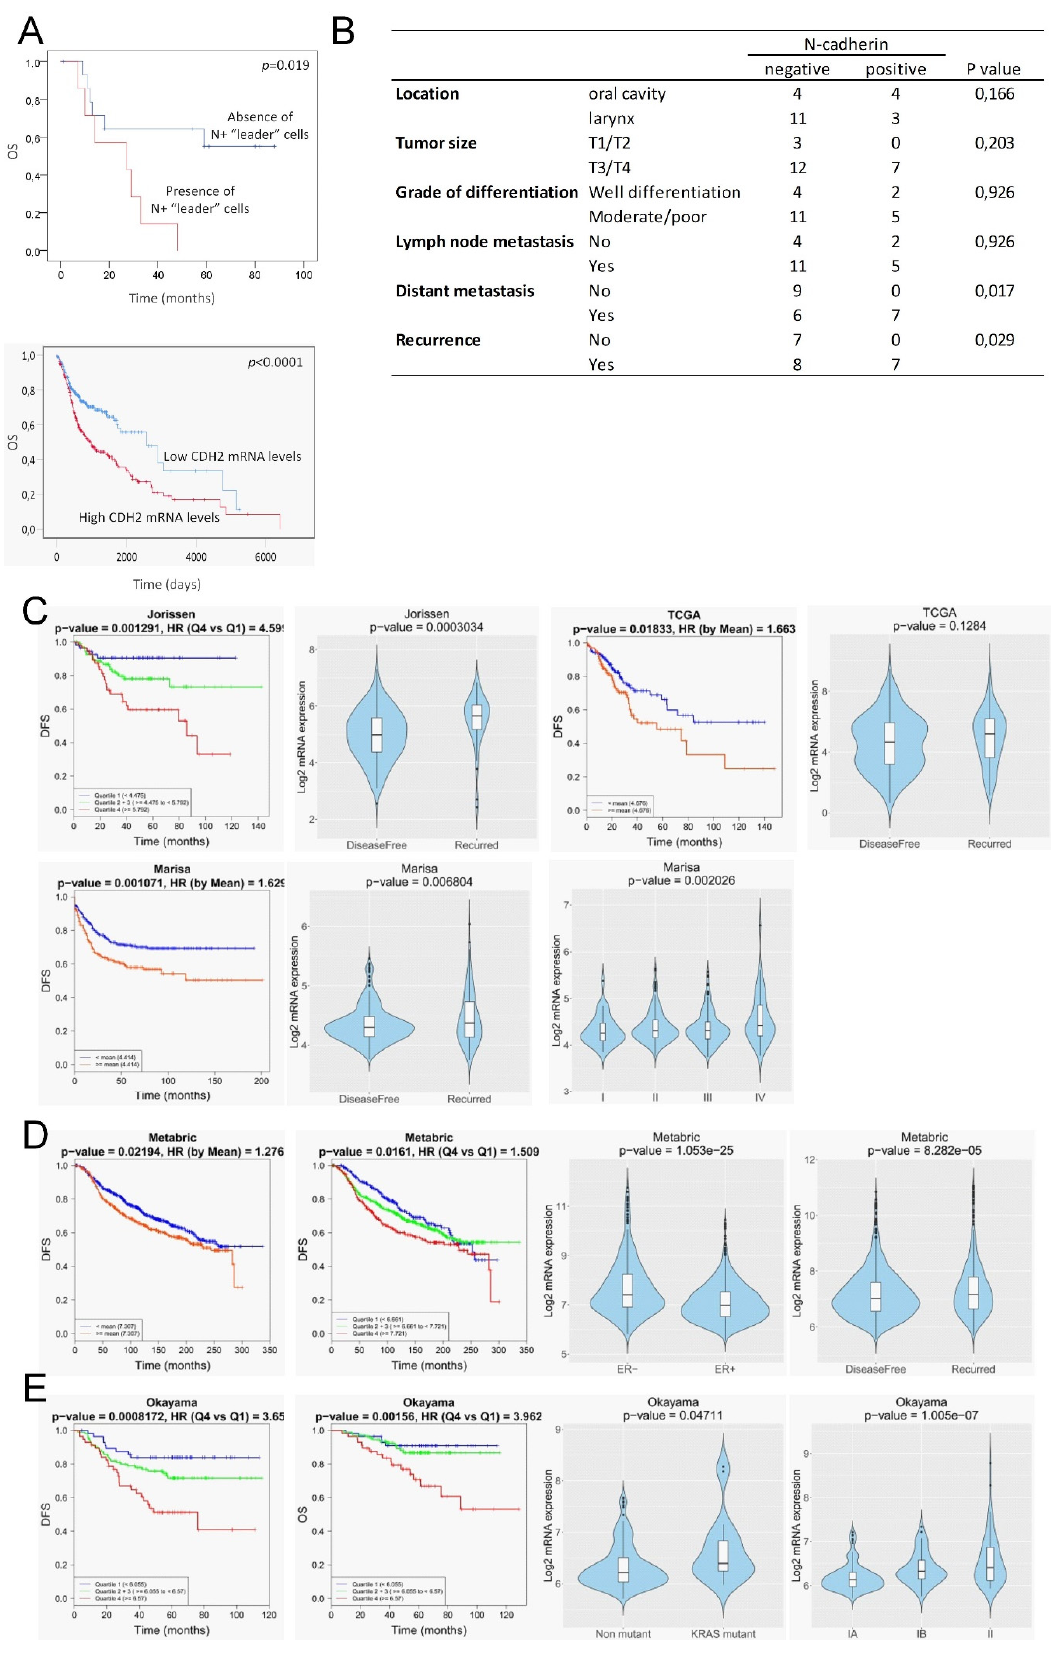
Figure 8. Clinical outcome associated with the N-cadherin expression in head and neck SCCs and